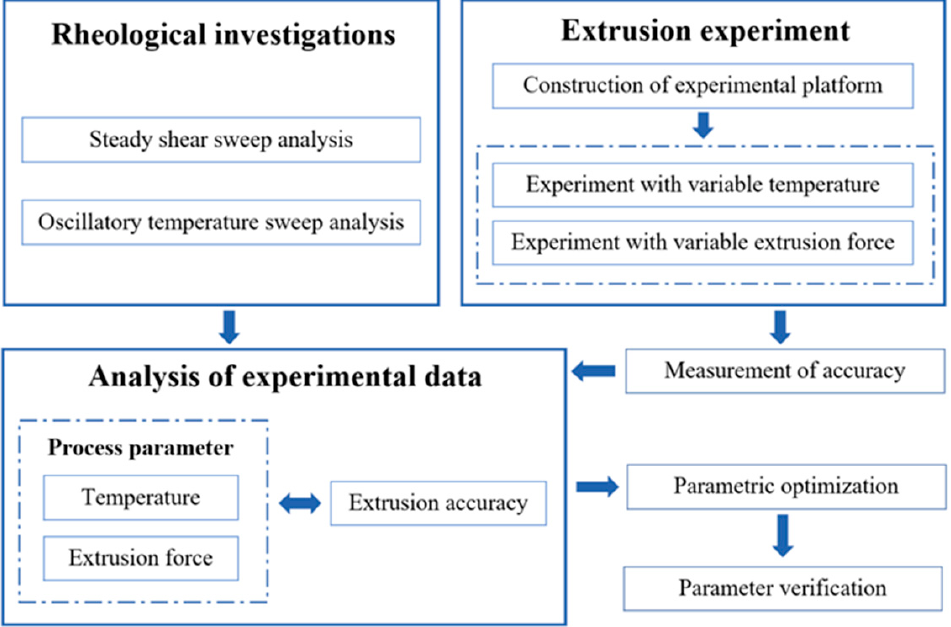
Figure 1. Schema of the experiment-based process parameter design method.